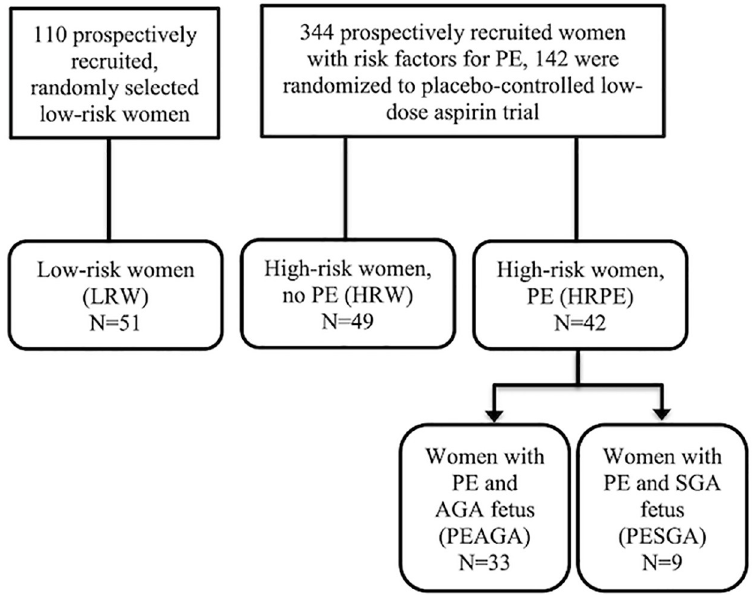
Fig 1. Flowchart of study cohort. PE = pre-eclampsia, SGA = small for gestational age, AGA = appropriate for gestational